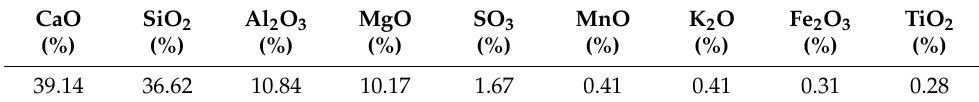
Table 1. Chemical composition of GGBFS.